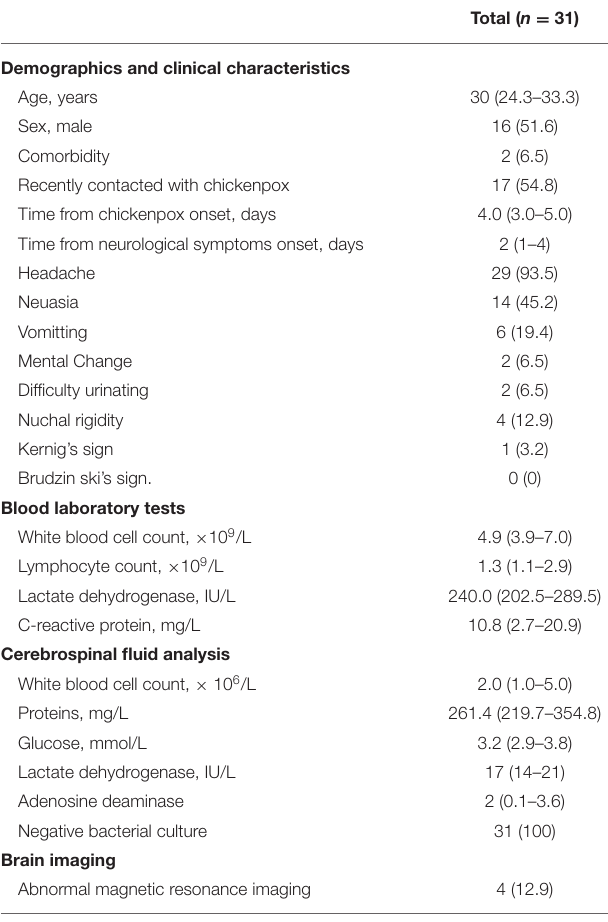
TABLE 1 | Clinical, laboratory, and imaging characteristics of the 31 patients hospitalized for screening of varicella-zoster virus (VZV) central nervous system (CNS)